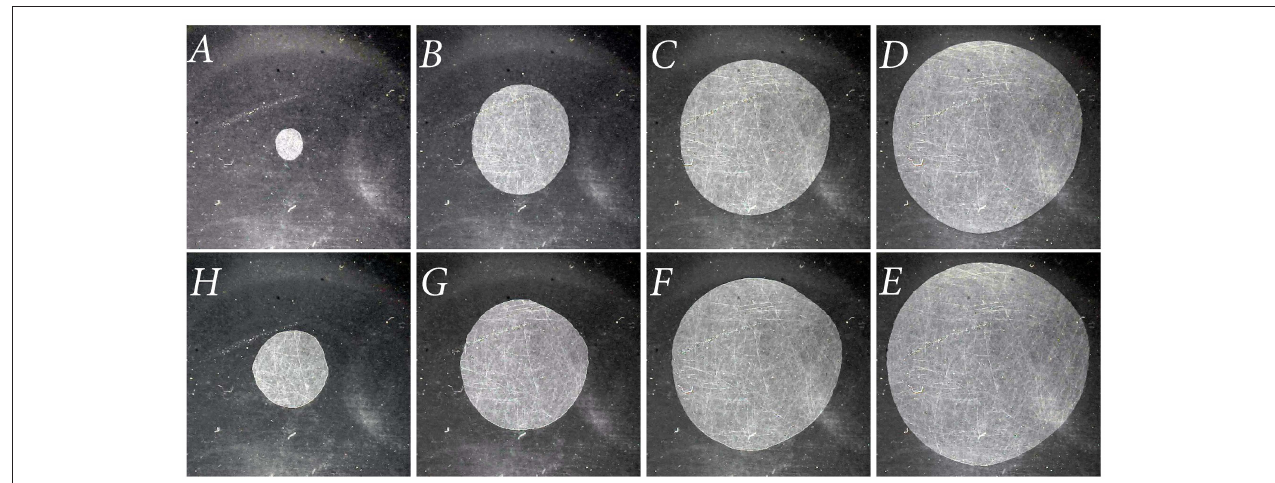
FIGURE 3 | Snapshots of the contact configuration with size 17mm × 17mm corresponding to the stages in the first loading cycle in Figure 2 . Panels (A–H) correspond to points A – H in Figure 2 .